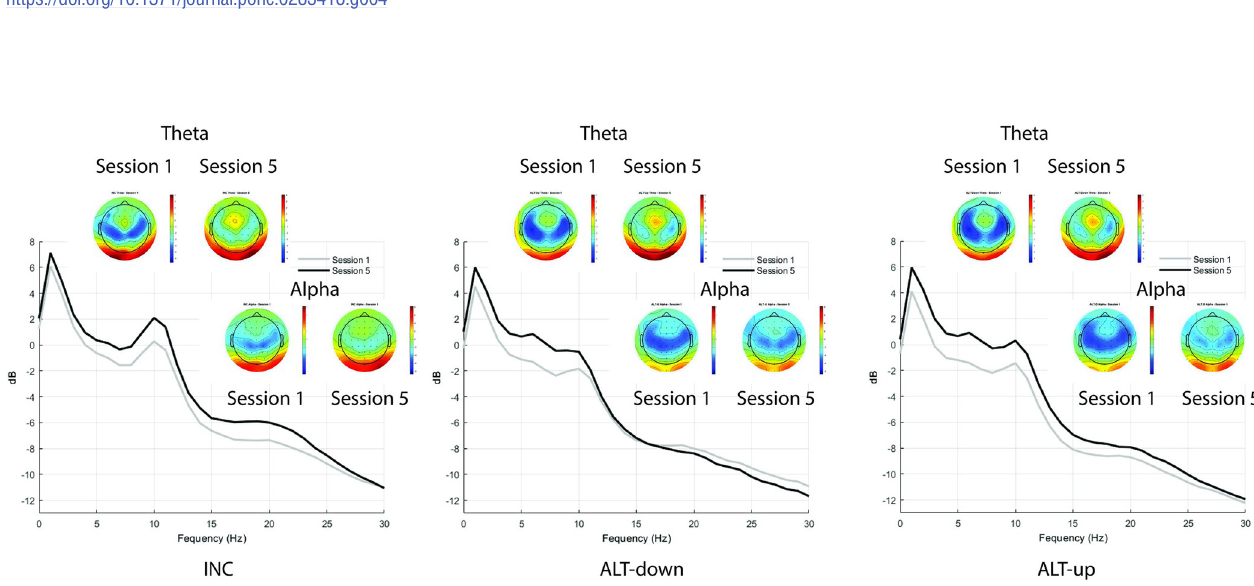
PLOS ONE | https://doi.org/10.1371/journal.pone.0283418 March 23,